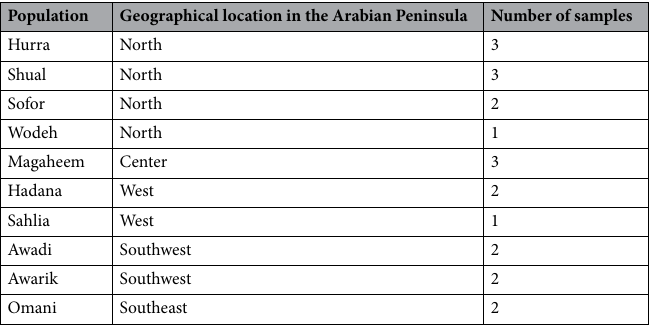
Table 2. Dromedary camel populations from Arabian Peninsula included in the study, their geographical distribution and the number of samples in each